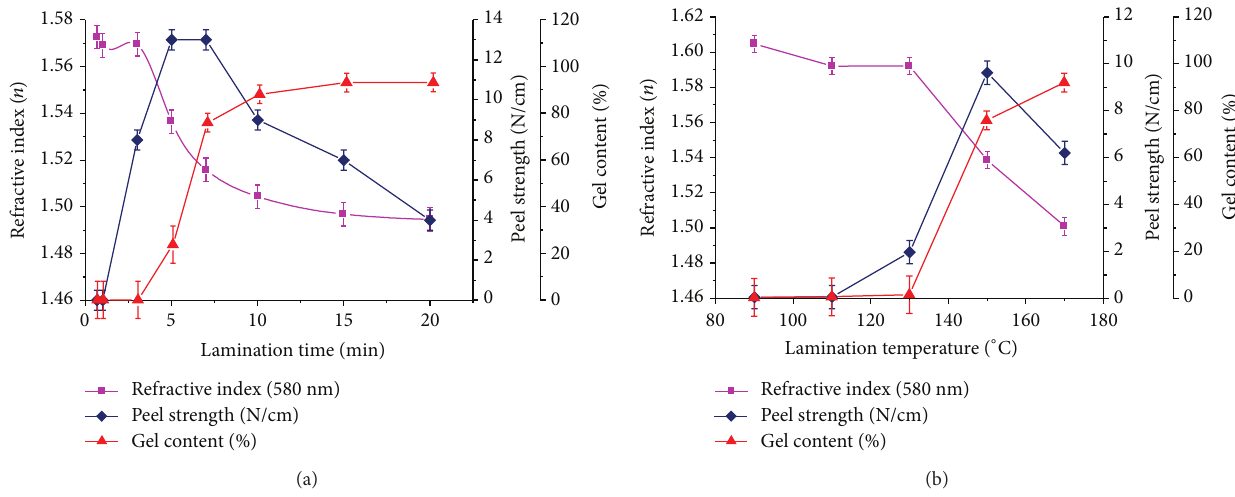
Figure 9: (a) The refractive index, gel content, and peel strength of EVA versus the lamination time at a fixed lamination temperature of 150 ∘ C. (b) The refractive index, gel content, and peel strength of EVA as a function of the lamination temperature for a fixed lamination time of 7